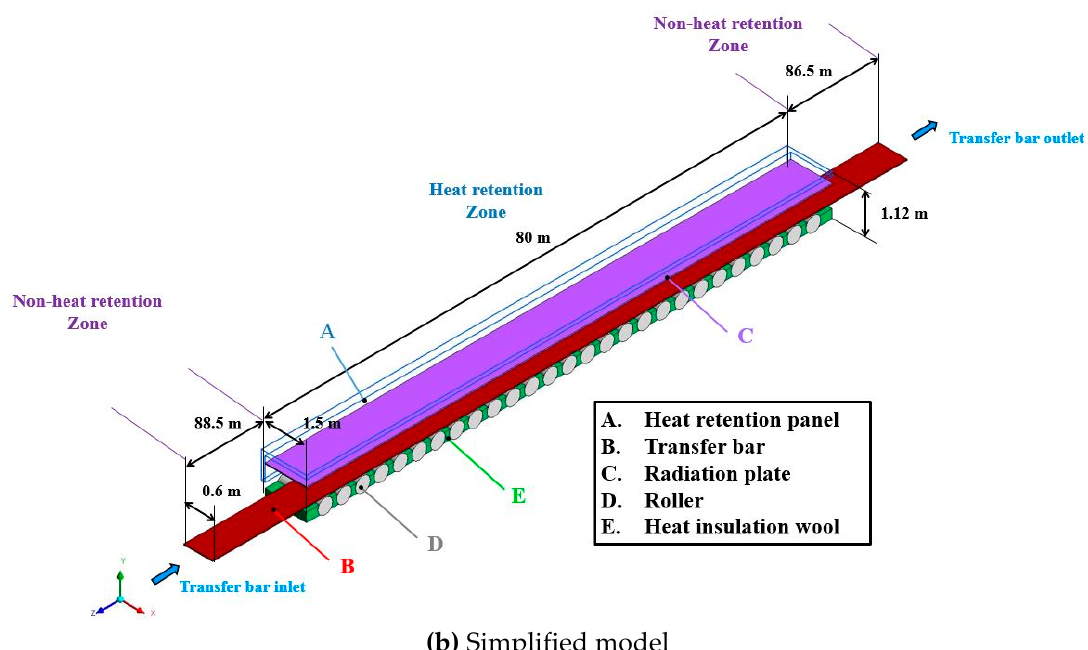
Figure 3. Physicals models of the acting-type heat retention panel.